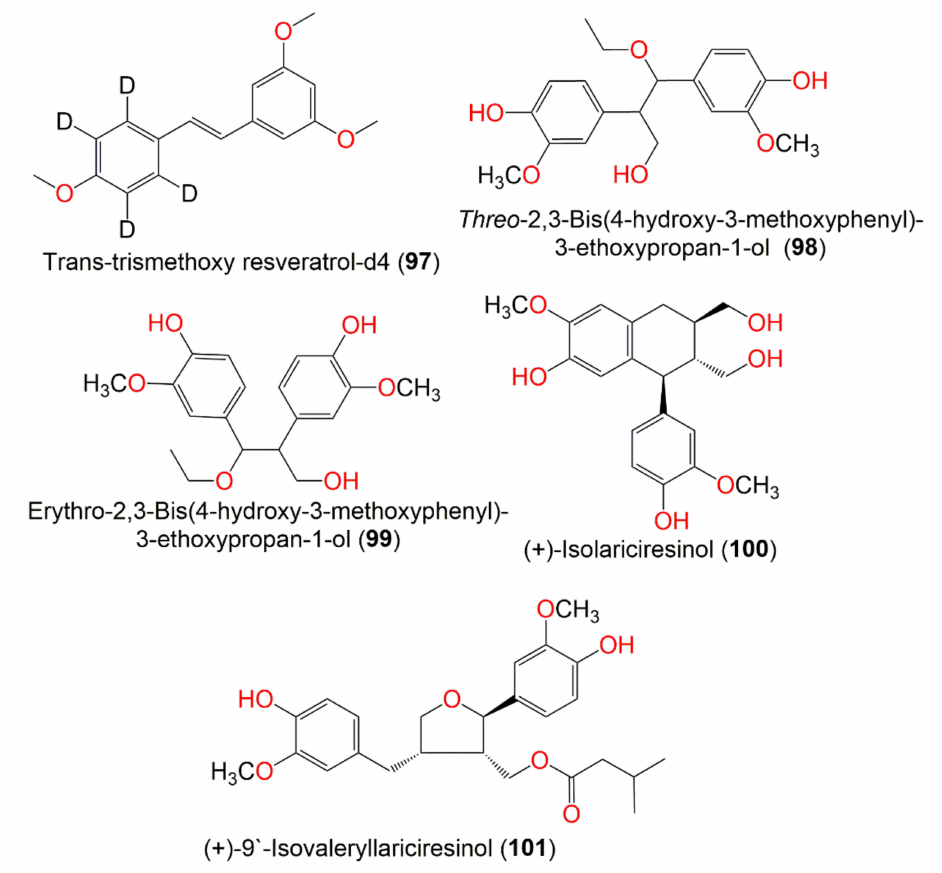
Figure 11. Structures of compounds 97 – 101